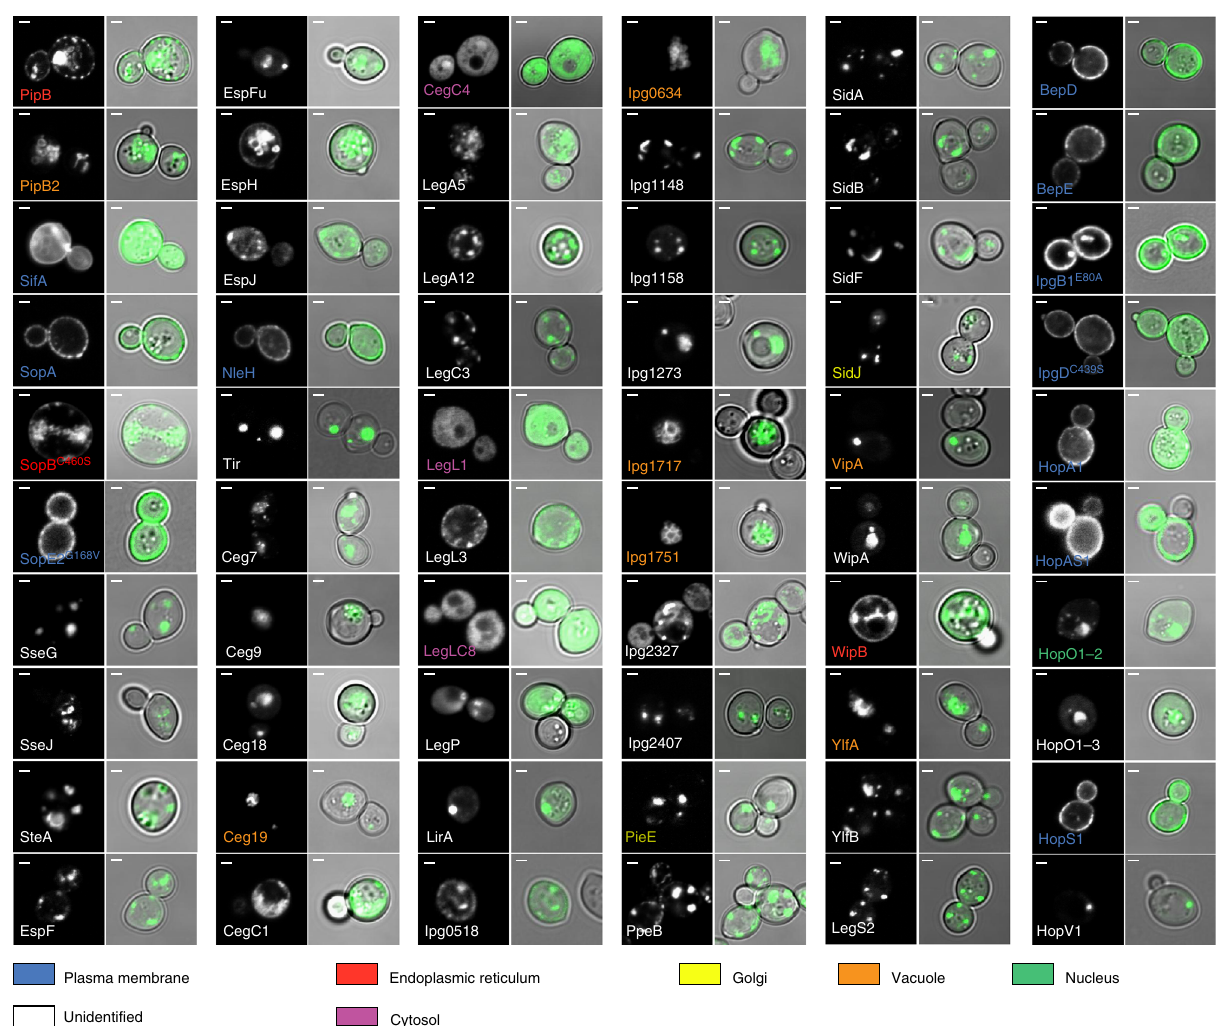
Fig. 3 Bacterial effector protein localization in yeast. Subcellular localization of EGFP-tagged membrane-interacting effectors in yeast. Scale bar is 1 μ